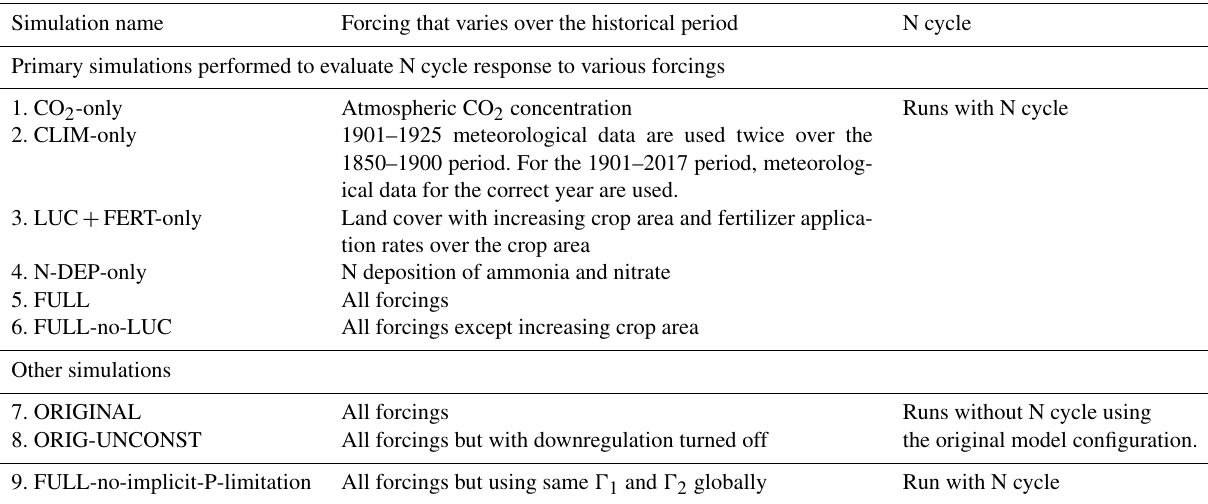
Table 1. Historical simulations performed over the period 1851–2017 to evaluate the model’s response to various forcings. All forcings are time varying. All forcings are also spatially explicit except atmospheric CO 2 , for which a globally constant value is